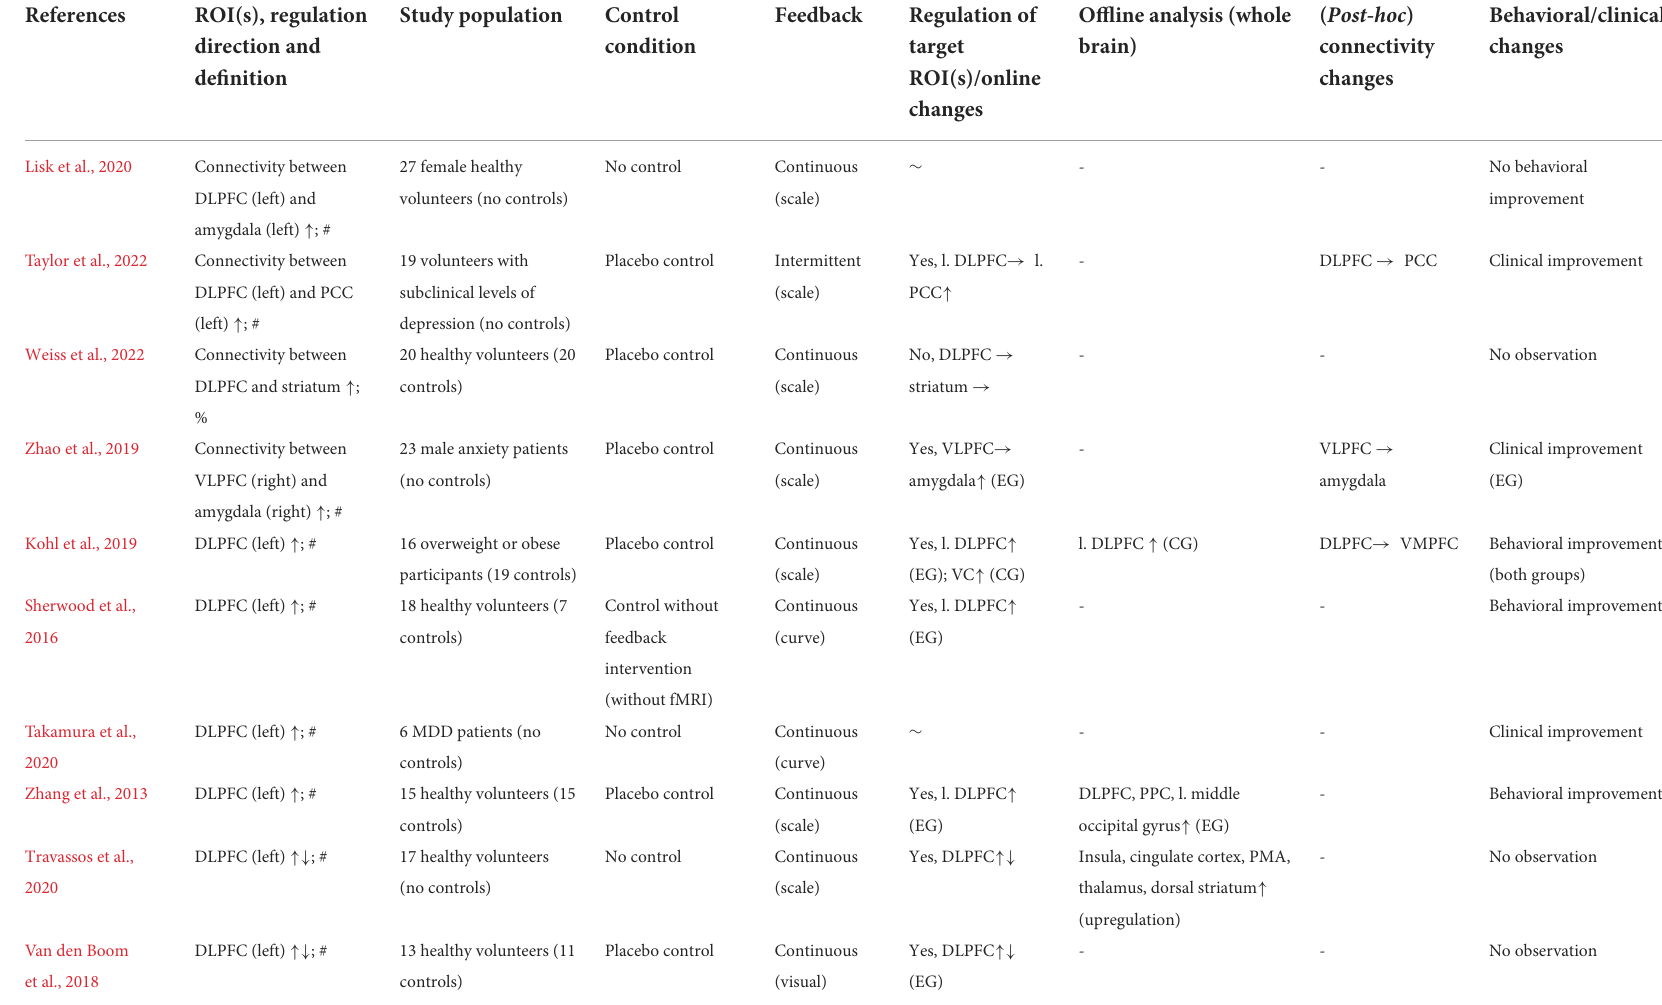
TABLE 2 Details of real-time fMRI neurofeedback studies with regulation target in the “associative